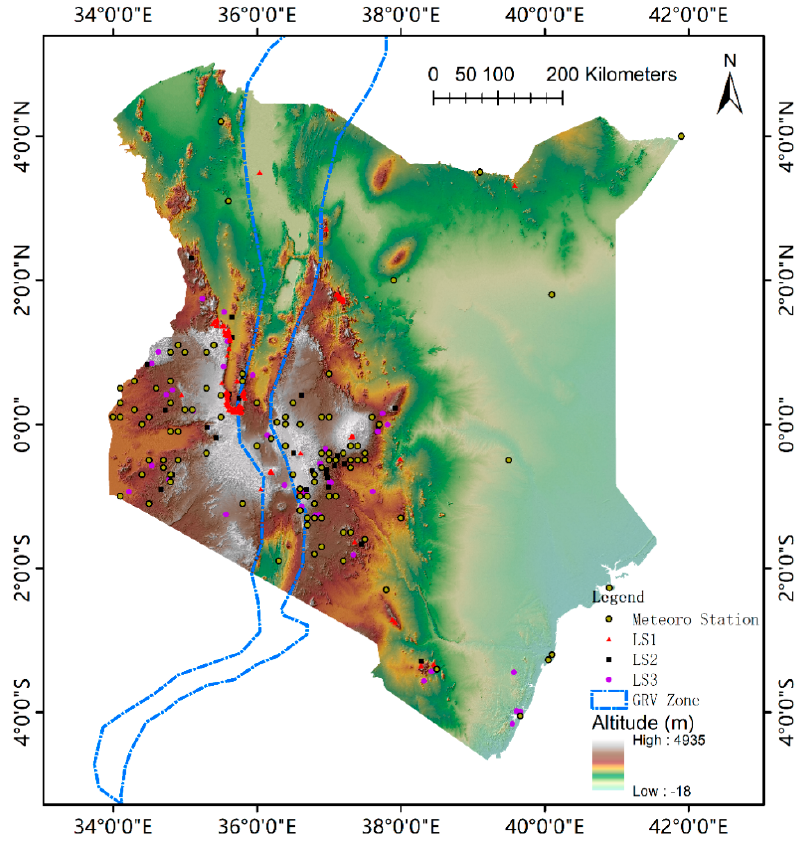
Figure 1. General conditions of Kenya and the spatial distribution of historical landslides in Kenya.